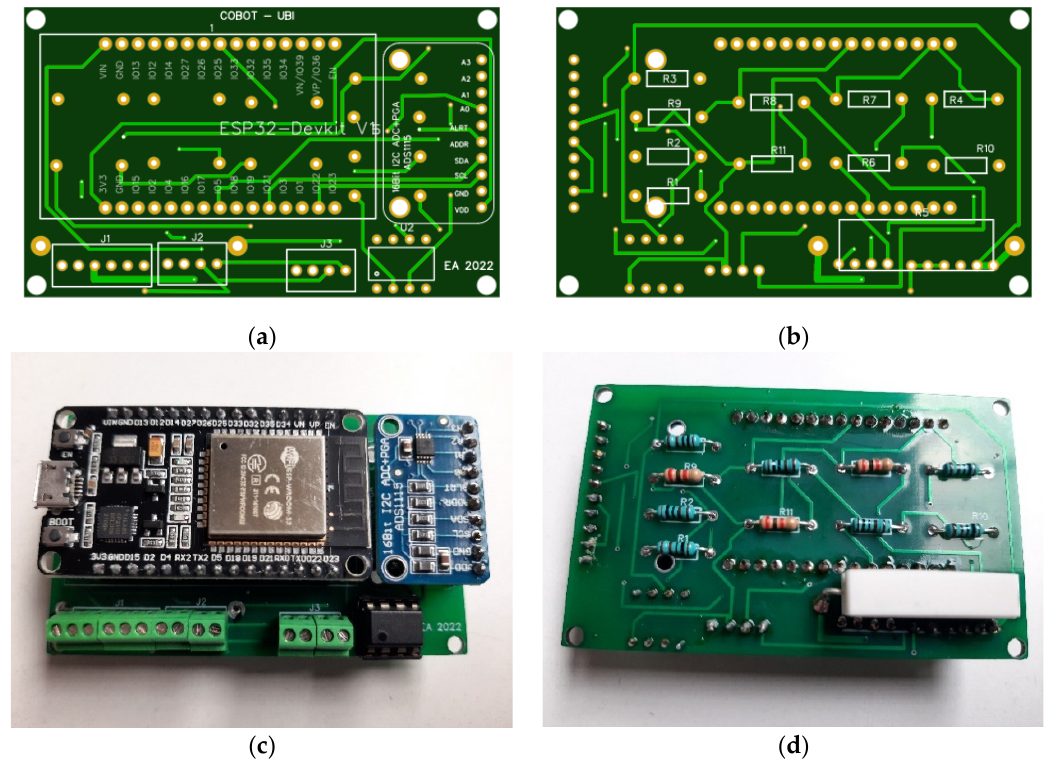
Figure 10. ( a ) PCB developed and printed: top view; ( b ) PCB designed and printed: bottom view; ( c ) PCB designed with soldered components: top view; ( d ) PCB designed with soldered components: bottom view.